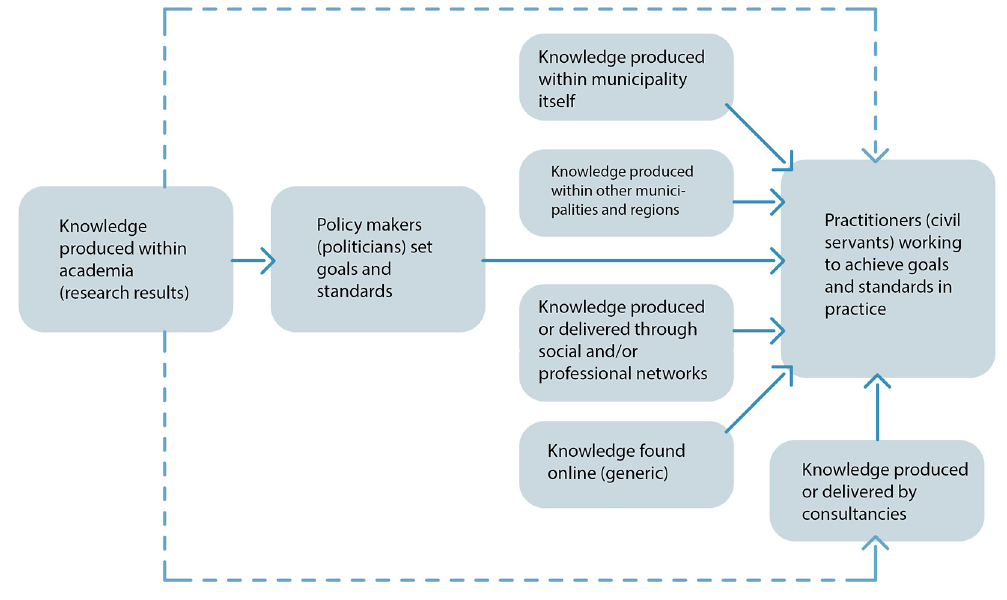
Figure 3. Knowledge access practices found among the interviewed civil servants.